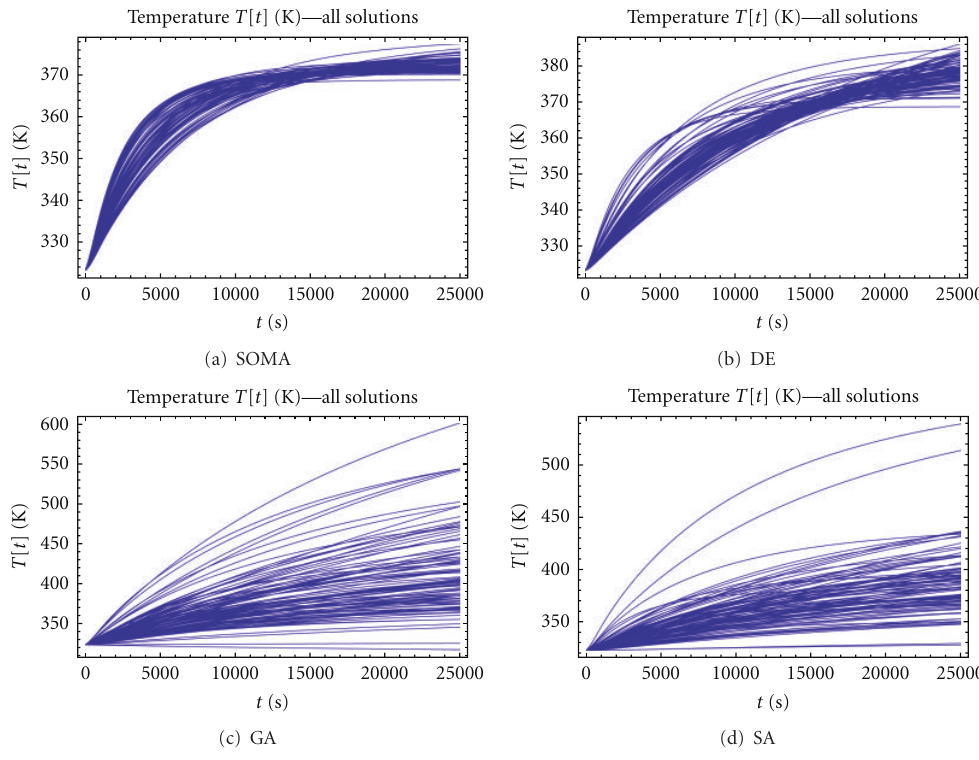
Figure 12: 100 simulations for T